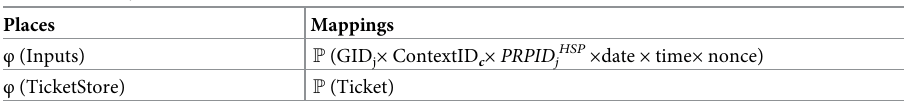
Table 3. Ticket ijk generation